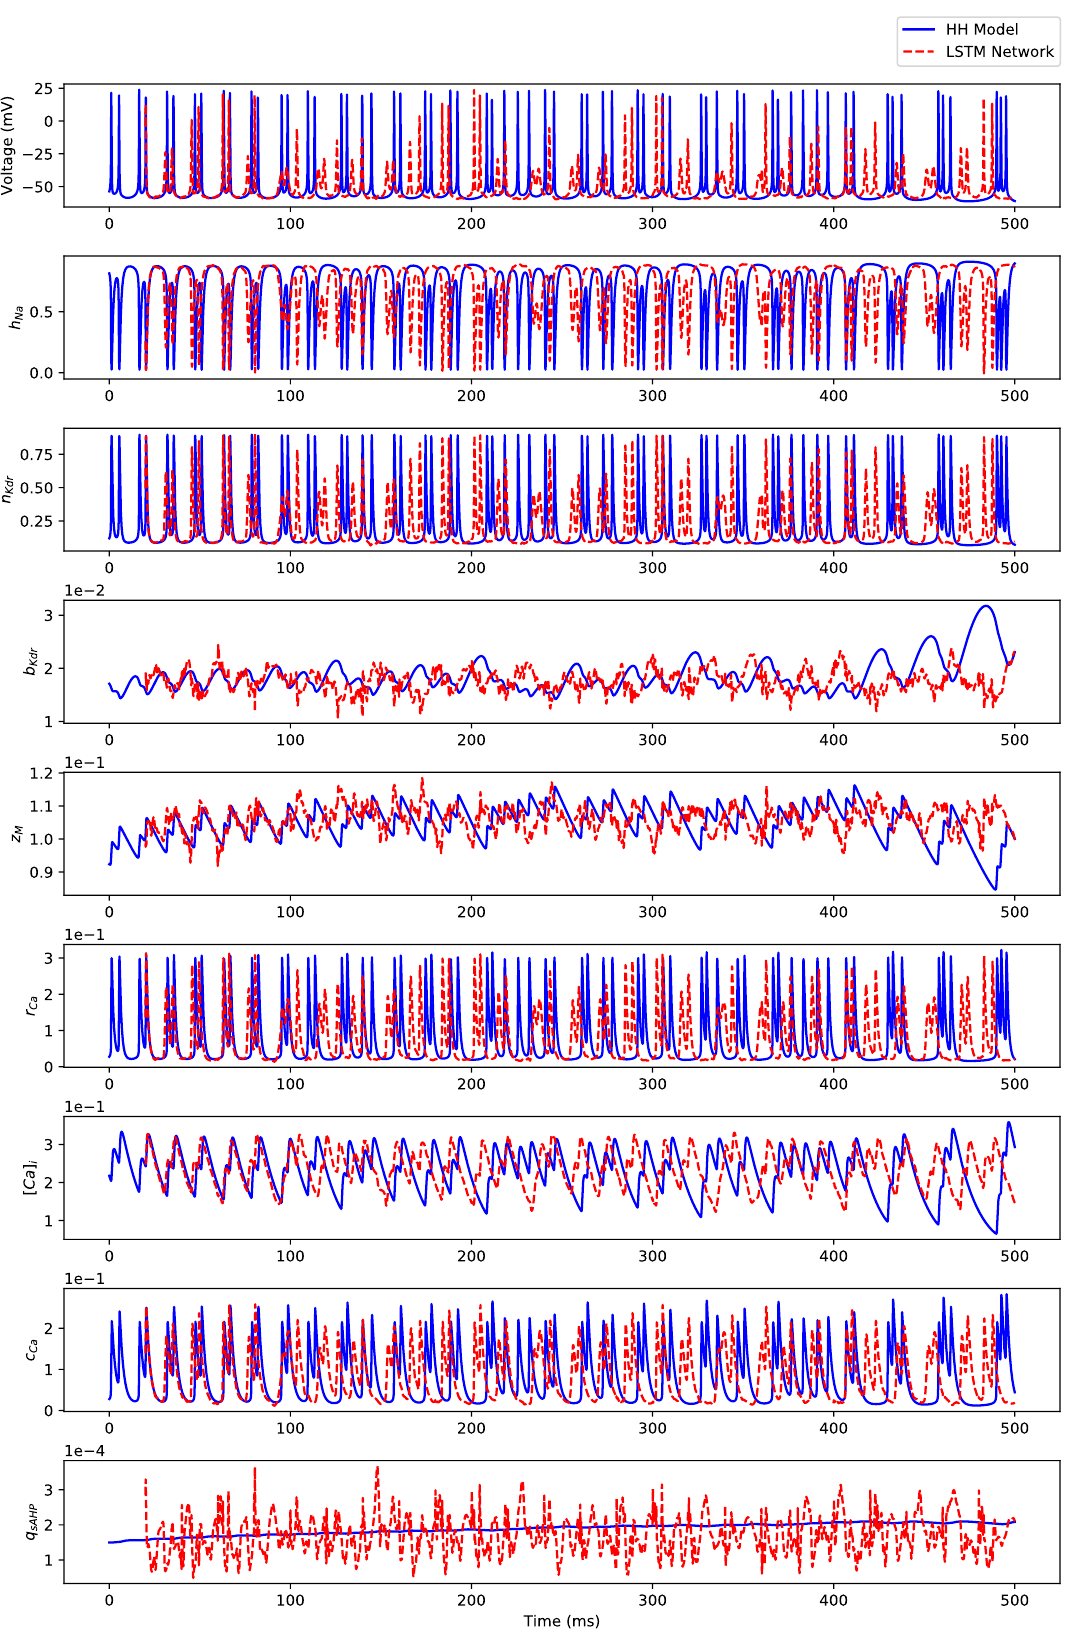
Figure A9. Comparison between the Hodgkin-Huxley model (“HH Model”) states’ dynamics and the iterative predictions of states’ dynamics using the 200 timesteps predictive horizon-based deep LSTM neural network (“LSTM Network”) in response to I = 1.5